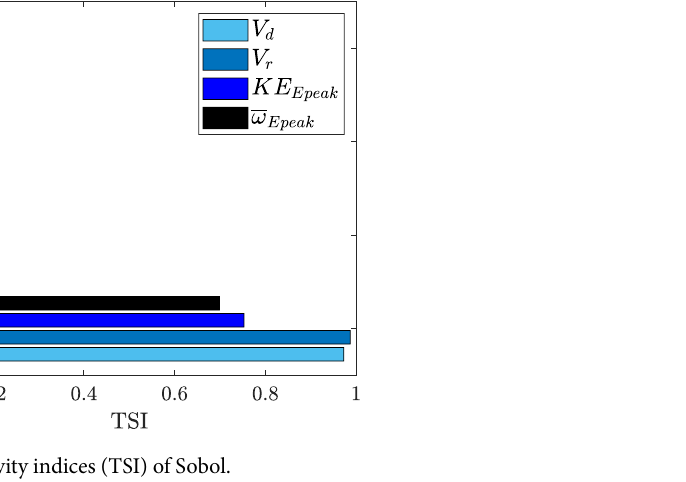
Figure 2. Total sensitivity indices (TSI) of